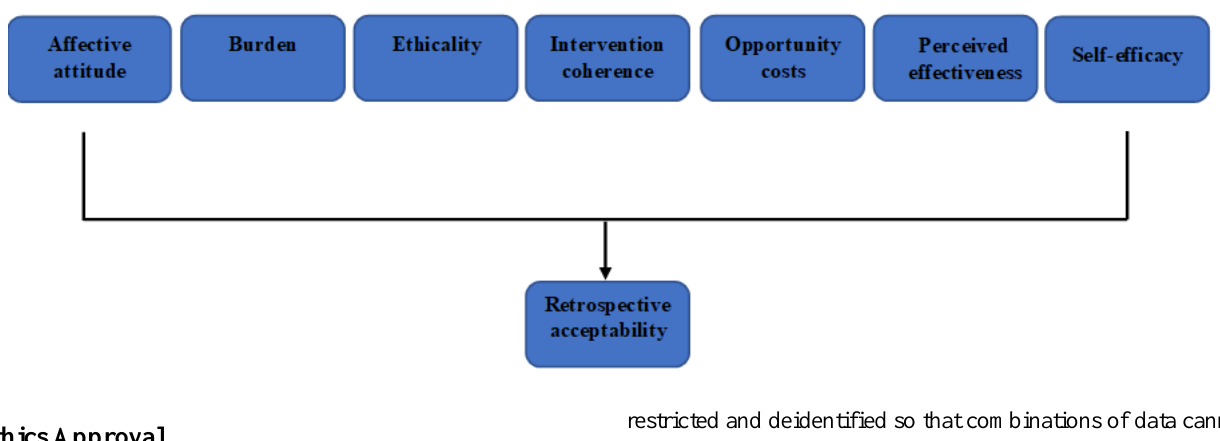
Figure 1. The Theoretical Framework of Acceptability. Data were collected retrospectively and explored using each of the 7 acceptability